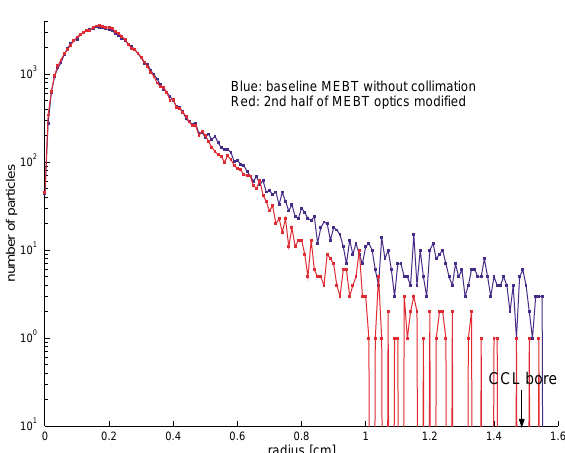
FIG. 13. (Color) Radial beam distribution at 171 MeV before (upper curve) and after (lower curve) MEBT optics modification. 87% of the beam tail with r . 9 mm is removed just due to optics change.